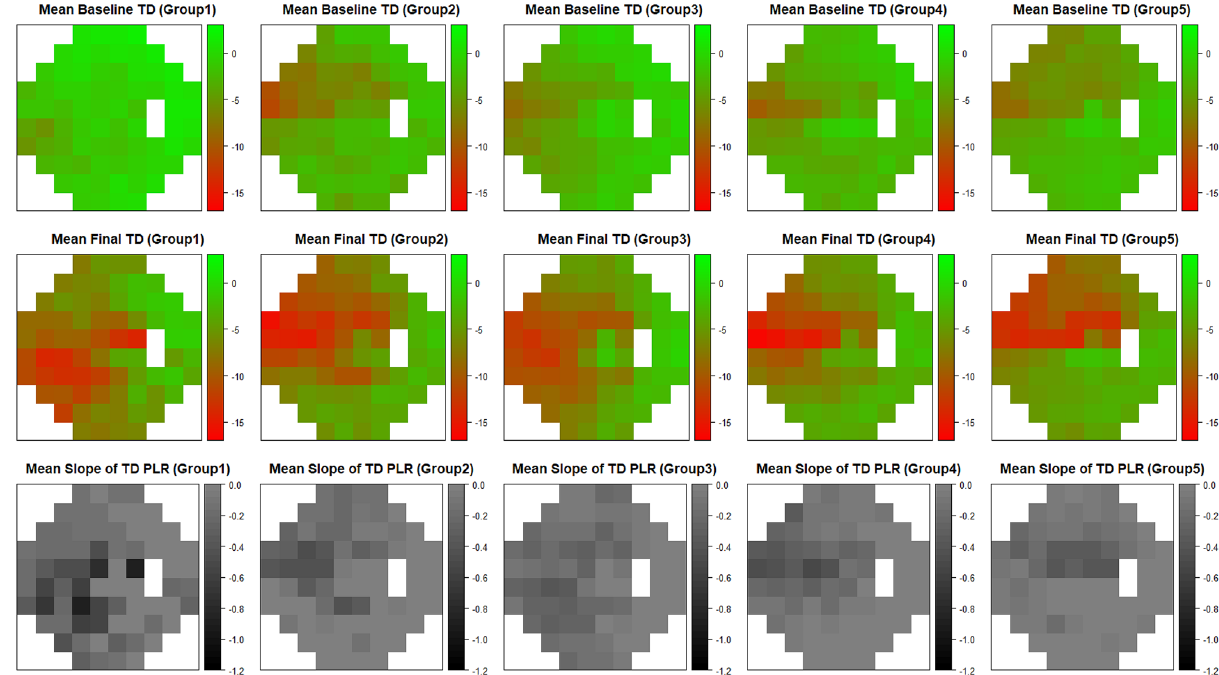
Figure 1. Relationship between the location of the maximum externally oblique border tissue (EOBT) and visual field (VF) progression. Columns show the five groups classified by location of the maximum EOBT. The first and second rows compare the mean total deviation plots (dB) at first and last visit, and the gray scale plot on the bottom row indicates the average slope of the total deviation plot at each point (dB/year). Progression rates are shown in grayscale in the bottom row; the lightest sectors showed the slowest progression while the darkest sectors showed the fastest progression. At the first visit, most of the groups showed VF defect at the superior hemifield except group 1, and at the last visit, the pattern of VF defect seems to be more obvious according to the location of the maximum EOBT. VF progression was dominantly in the inferior hemifield in group 1, whereas it was dominantly in the superior hemifield in group 5. TD = total deviation, PLR = point-wise linear regression.